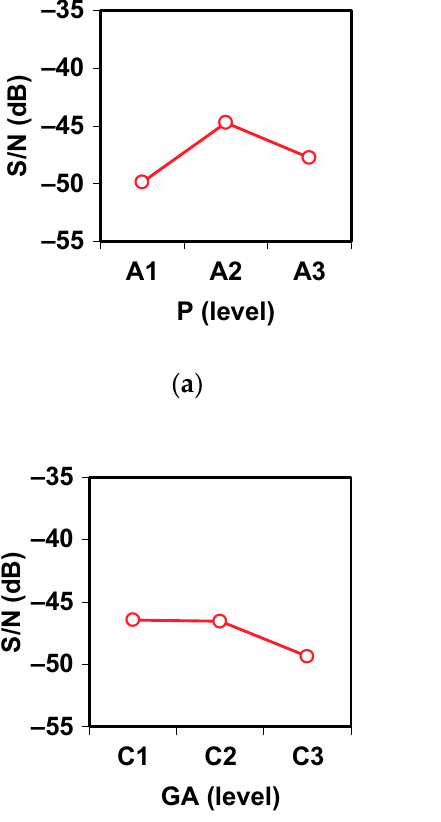
Power ( b ) Excess Air ( c ) Grate Area ( d ) Split